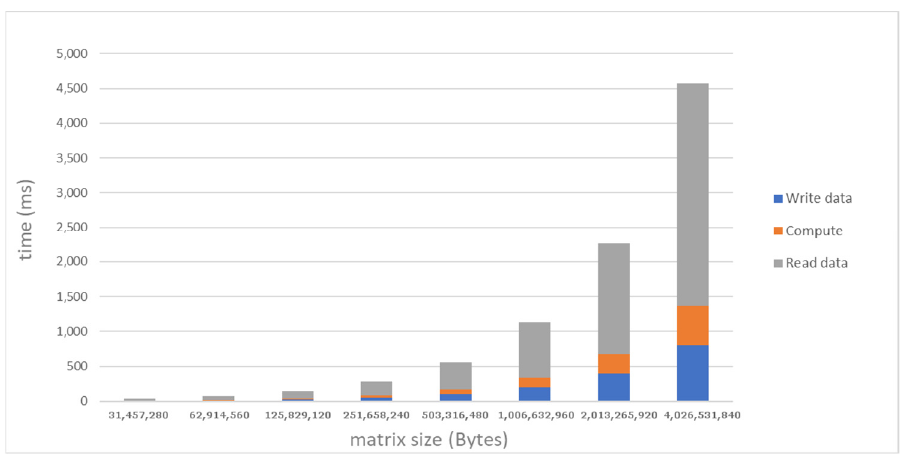
Figure 5. Performance of the stencil case study with remote direct accelerator memory access based on PCIe peer-to-peer communication, as measured in the baseline system along Path 2.